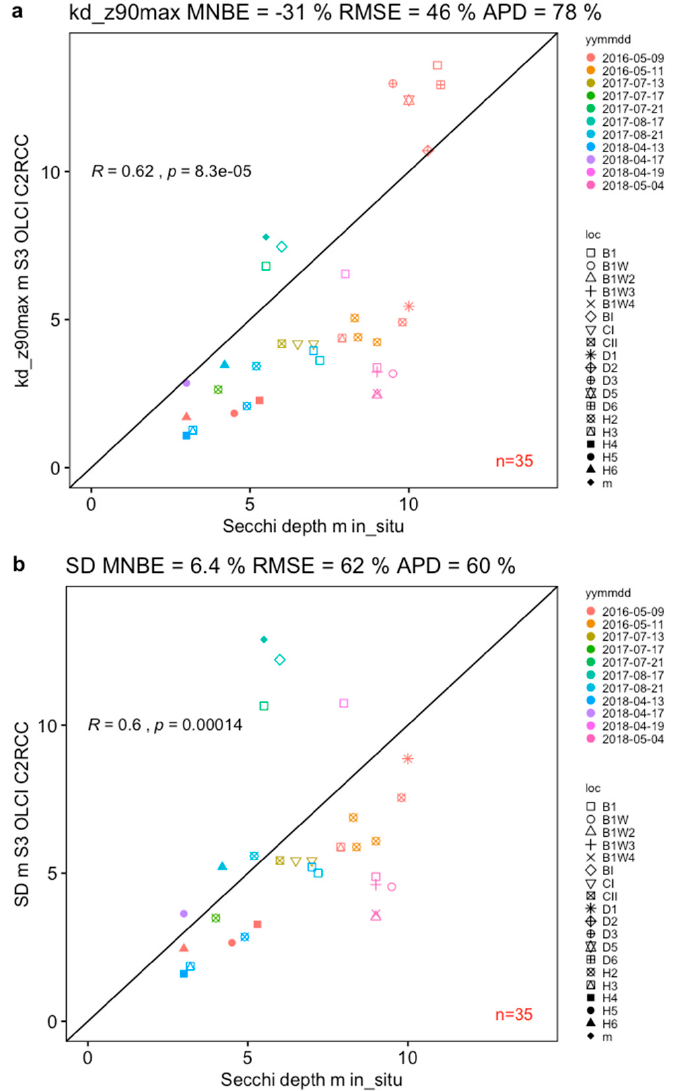
Figure 7. A proxy for Secchi depth ( a ) “kd_z90max”, and ( b ) the Secchi depth algorithm based on Kd (489) (diffuse attenuation coefficient at 489 nm) from Alikas et al. [24] derived from S3A OLCI data using the C2RCC with locally adapted parameters and compared to in-water Secchi depth measurements.